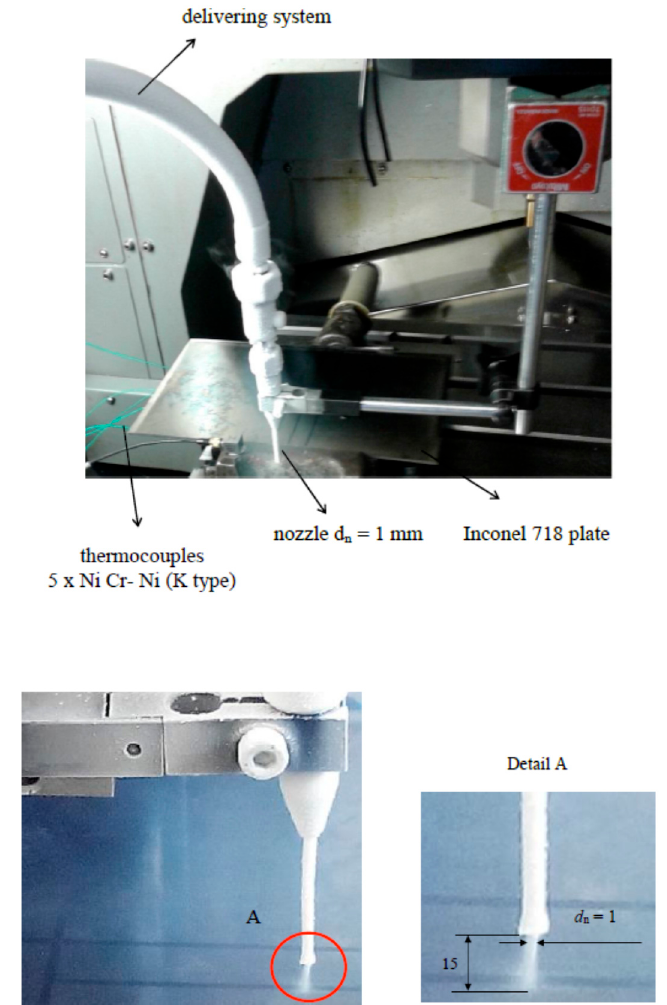
Figure 2. Experimental setup [10].